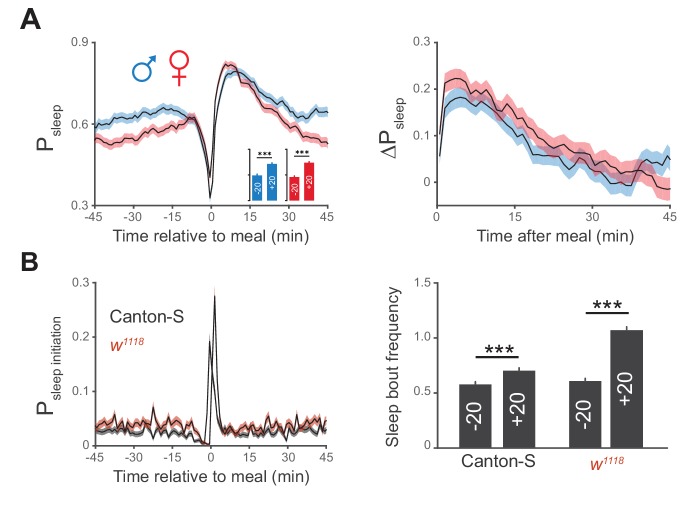
Postprandial sleep is sex independent.(A) Canton-S males (blue) and females (red) demonstrate similar increases in postprandial sleep. n = 672 meals from 30 males; 730 meals from 30 females; ***p<0.001, Wilcoxon matched-pairs sign rank test. (B) Probability of sleep initiation in 1 min windows surrounding feeding events for Canton-S (gray) and w1118 (red), with a quantification of sleep bout frequency in the 20 min before (+20) and after (−20) feeding events. ***p<0.001, Wilcoxon matched-pairs sign rank test.